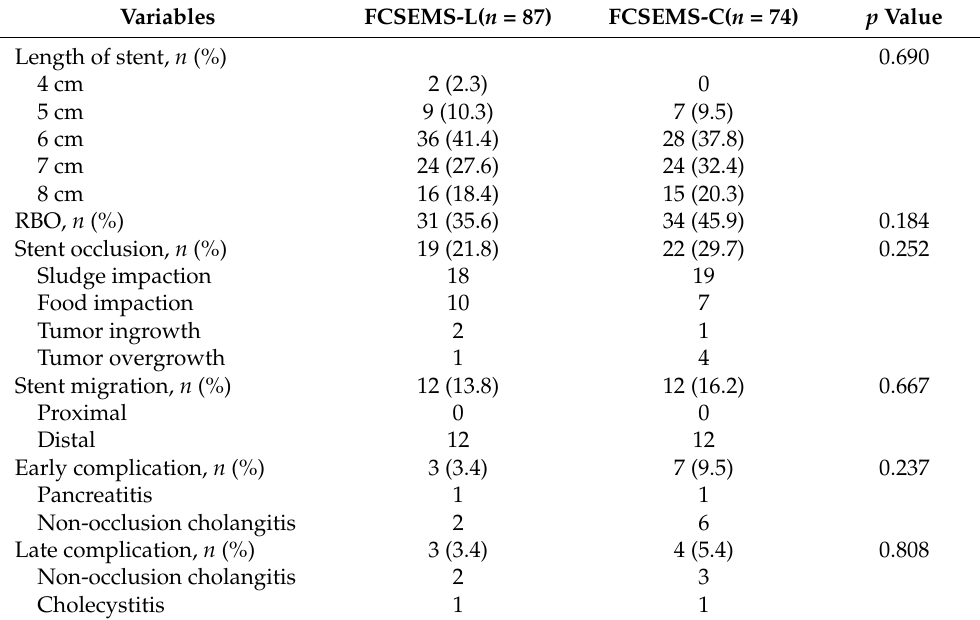
Table 2. Clinical outcomes of FCSEMS-L and FCSEMS-C.